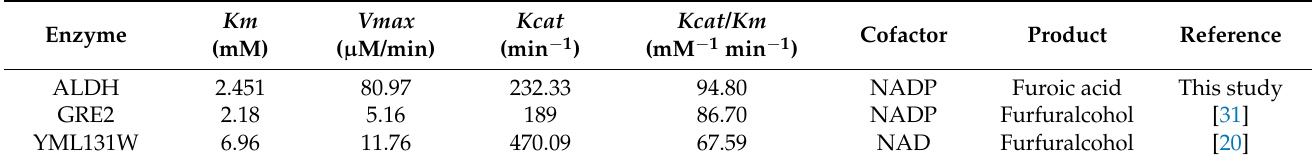
Figure 6. Kinetic analysis of W826-RS0111485 for furfural. Table 1. Kinetic parameters of different enzymes when furfural was used as a substrate.